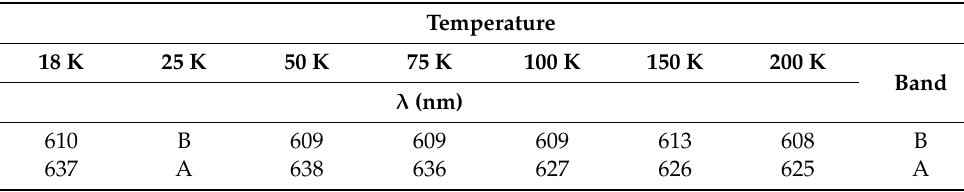
Table 3. Temperature dependence of the bands for